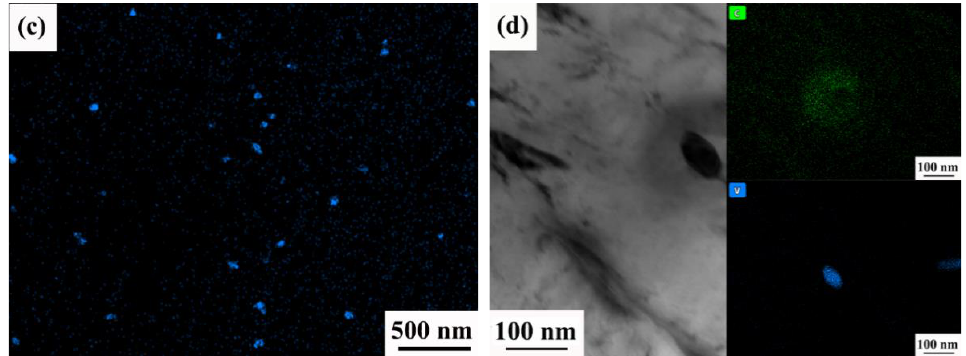
Figure 9. TEM map scanning images of different heat treatment processes ( a , d ) 950 °C; ( b ) 950 °C – 870 °C; and ( c ) 950 °C – 848 °C.